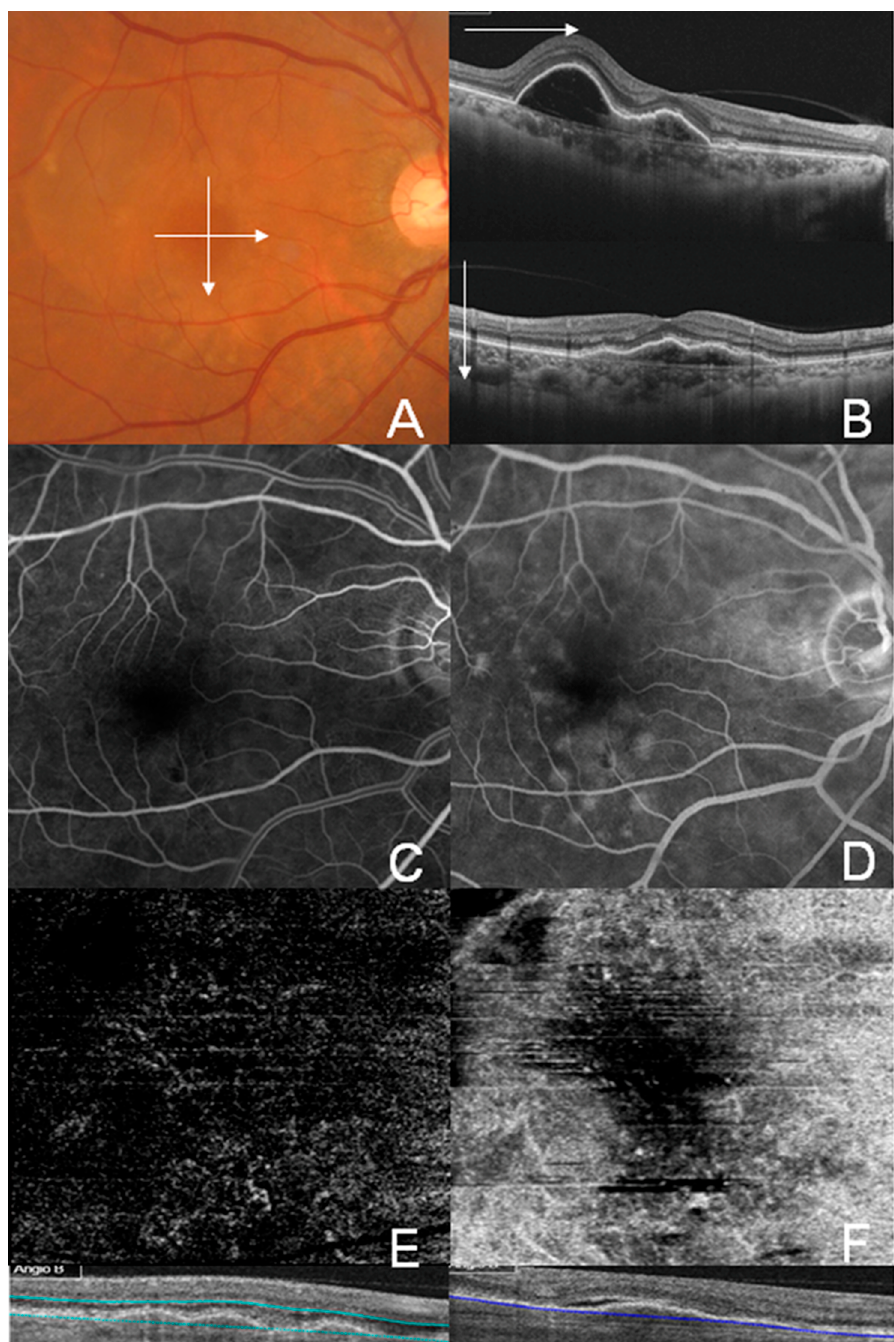
Figure 3. Multimodal imaging of a 63-year-old female showing type 1 choroidal neovascularization (CNV), classified as Group C (poorly circumscribed CNV). ( A ) Color fundus photograph showing a broad orange nodule on the posterior pole corresponding to a large pigment epithelial detachment (PED); ( B ) Swept-source optical coherence tomography (OCT) B-scan image on the horizontal and vertical 6 mm of the fovea showing vascularized and serous PED; ( C , D ) Early and late phase images of the fluorescein angiography showed ill-defined occult type CNV. ( E , F ) OCT angiography images of the outer retina layer ( E ) and choriocapillaris ( F ) showed poorly circumscribed vascular contour.